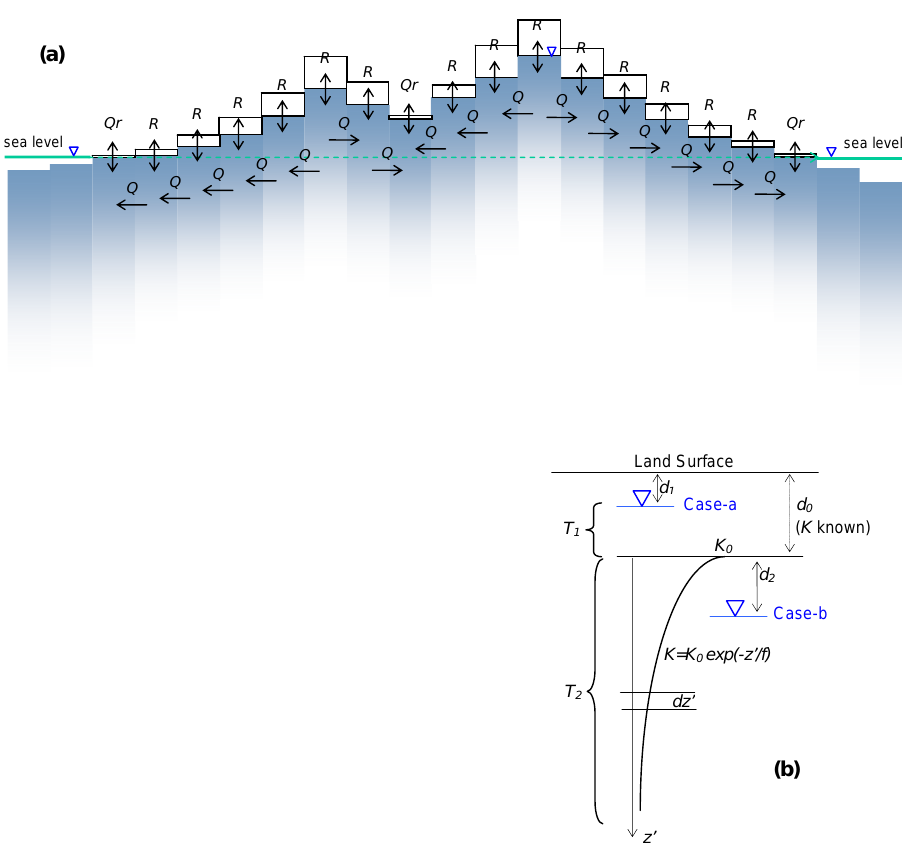
Fig. 2. (a) Schematic of the 2-D groundwater model to simulate the climate (recharge R ), terrain (lateral flow Q ) and sea level (boundary condition) control on water table depth over a continent. In upland cells, recharge balances lateral groundwater divergence to lower neighbors. In valley or coastal cells, lateral groundwater convergence discharges into wetlands and rivers, (b) details of calculating flow transmissivity, T, for Case-a, water table within the depth of known soil hydraulic conductivity ( K ), and Case-b, water table below the known depth where K is assumed to decrease exponentially with depth.